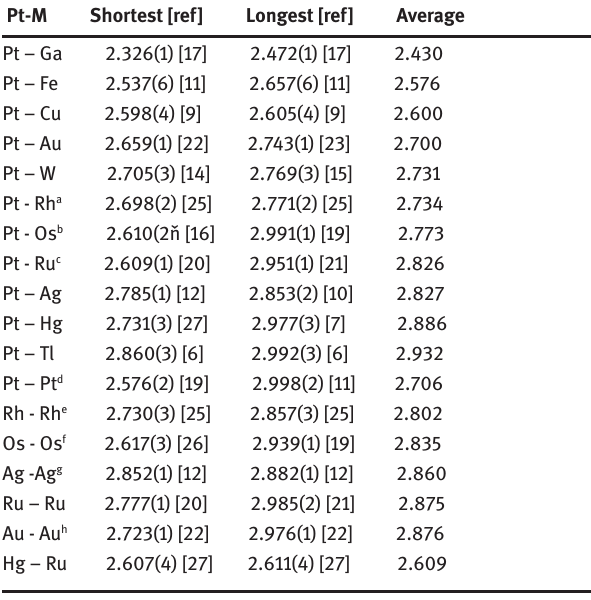
Table 2. Summary of the Pt-M, M-M and M-M´ bond distances (< 3.0 Å) in heteroheptanuclear platinum